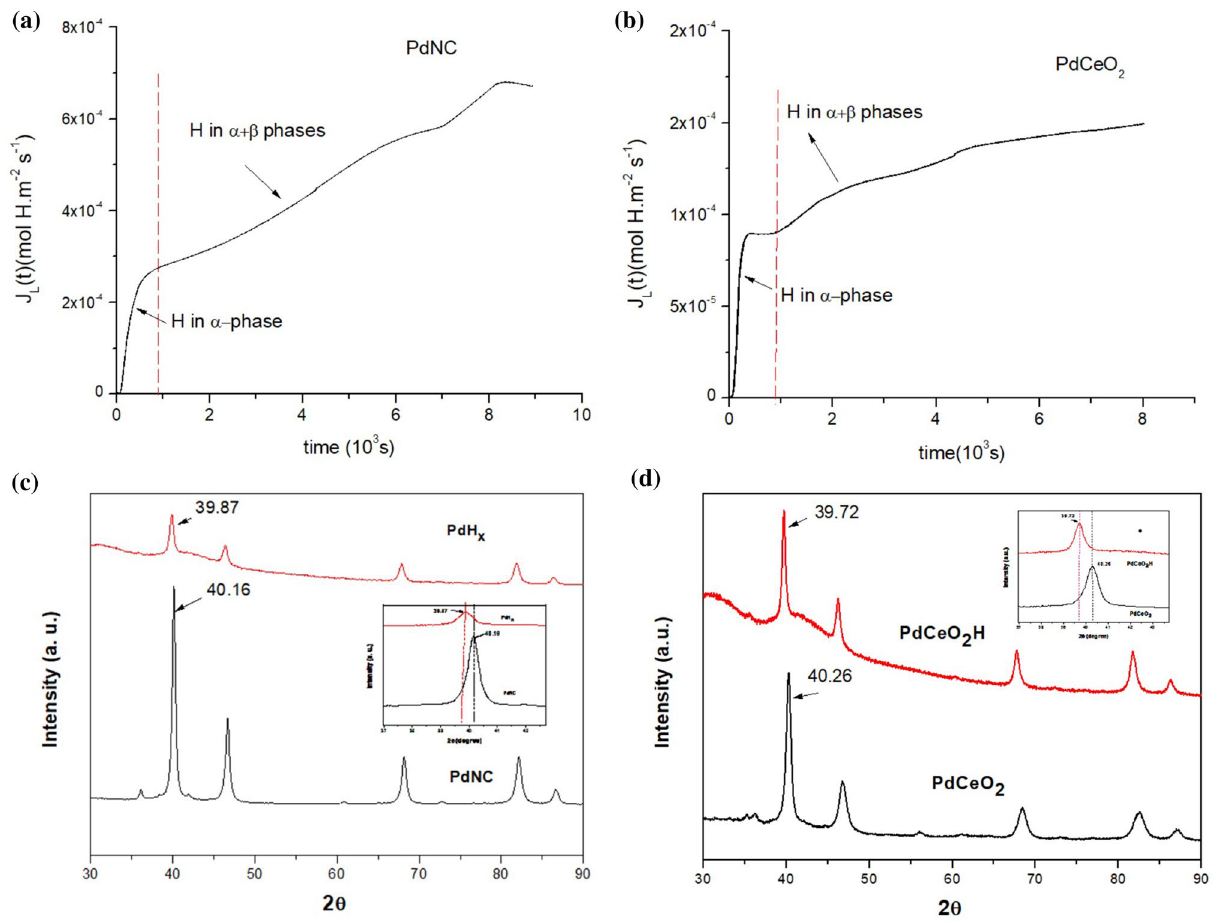
Figure 1. Hydrogen permeation curves obtained with current density of 5 mA/cm 2 for pure Pd ( a ) and PdCeO 2 internally oxidized ( b ). XRD pattern for PdNC ( c ) and PdCeO 2 ( d ) before and after